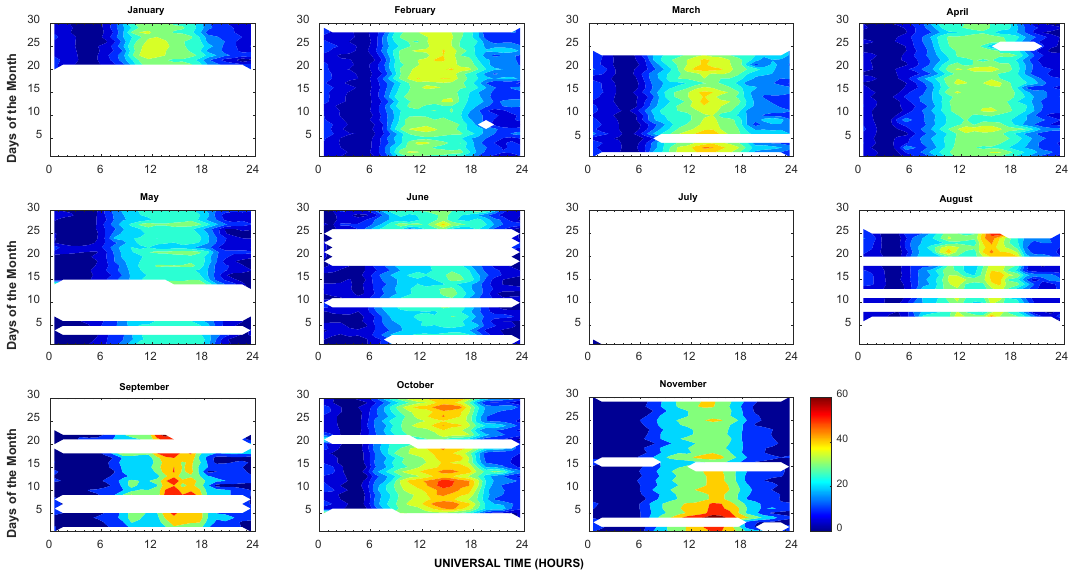
Figure 5. Monthly TEC variation over the BOWEN CASES GPS during 2021.